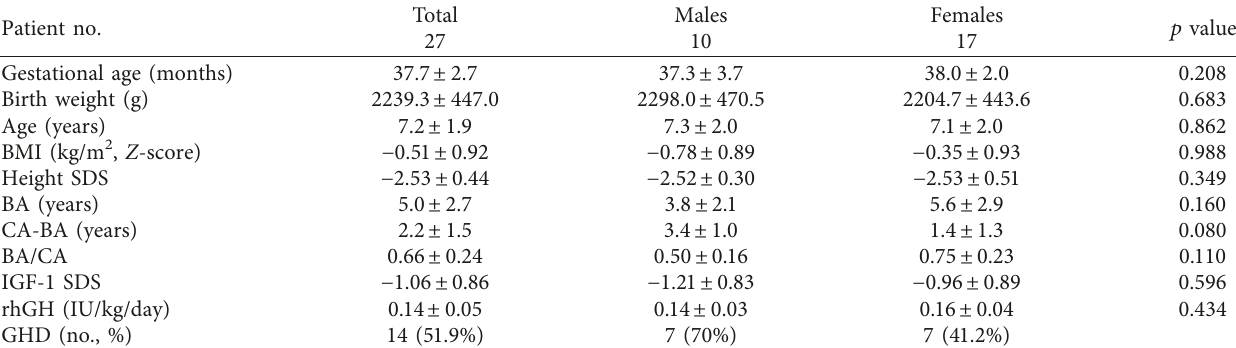
Table 1: Clinical and laboratory characteristics of study patients.